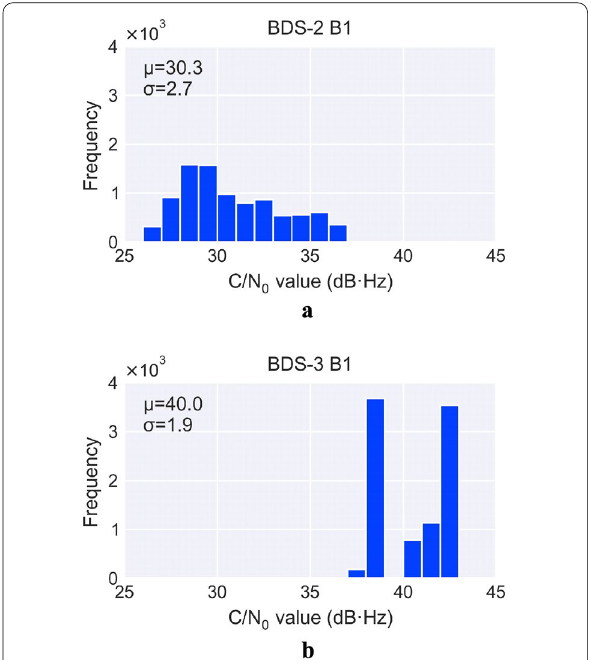
Fig. 10 Histogram and statistics of the C/N0 measurements of a BDS-2 and b BDS-3 satellites at elevation angles above